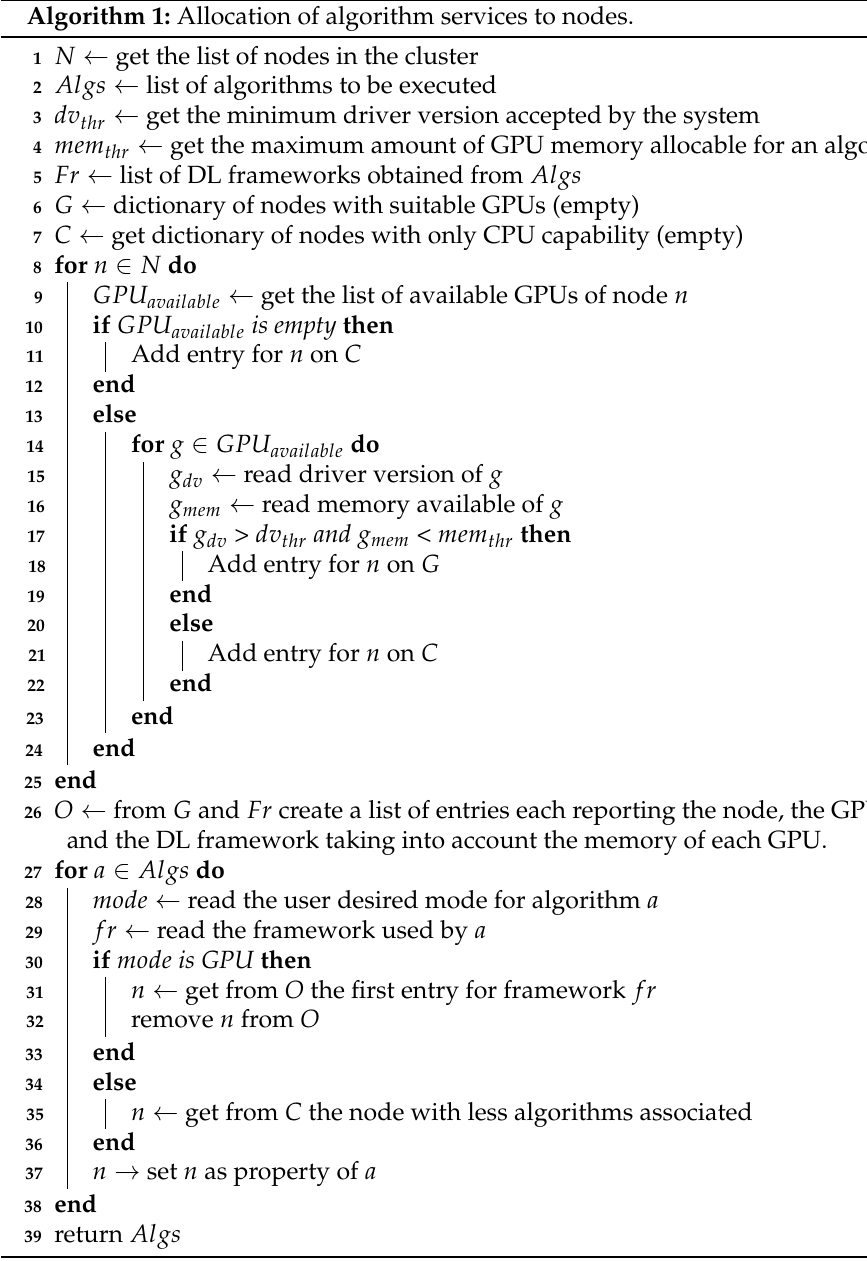
Algorithm 1: Allocation of algorithm services to